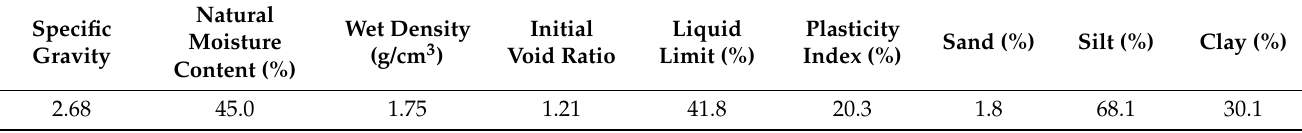
Table 1. Physical properties of soft